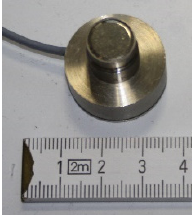
Figure 9. Picture of the microphone, B&K Type 4189.